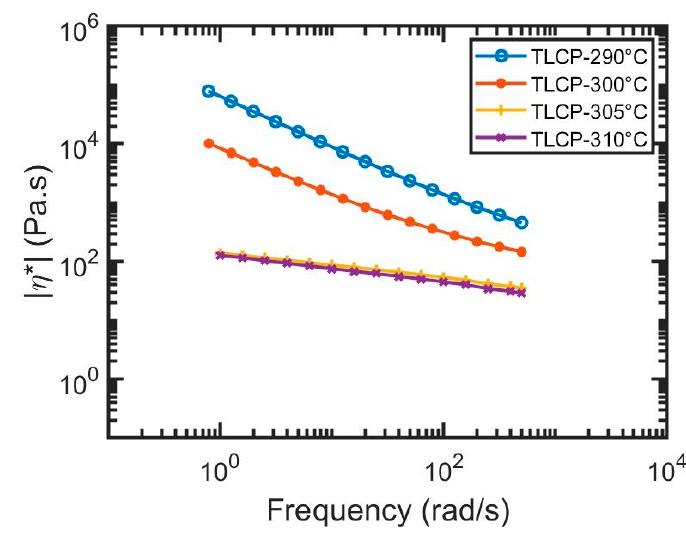
Figure 2. Complex viscosity of TLCP at temperatures from 290 to 310 °C.